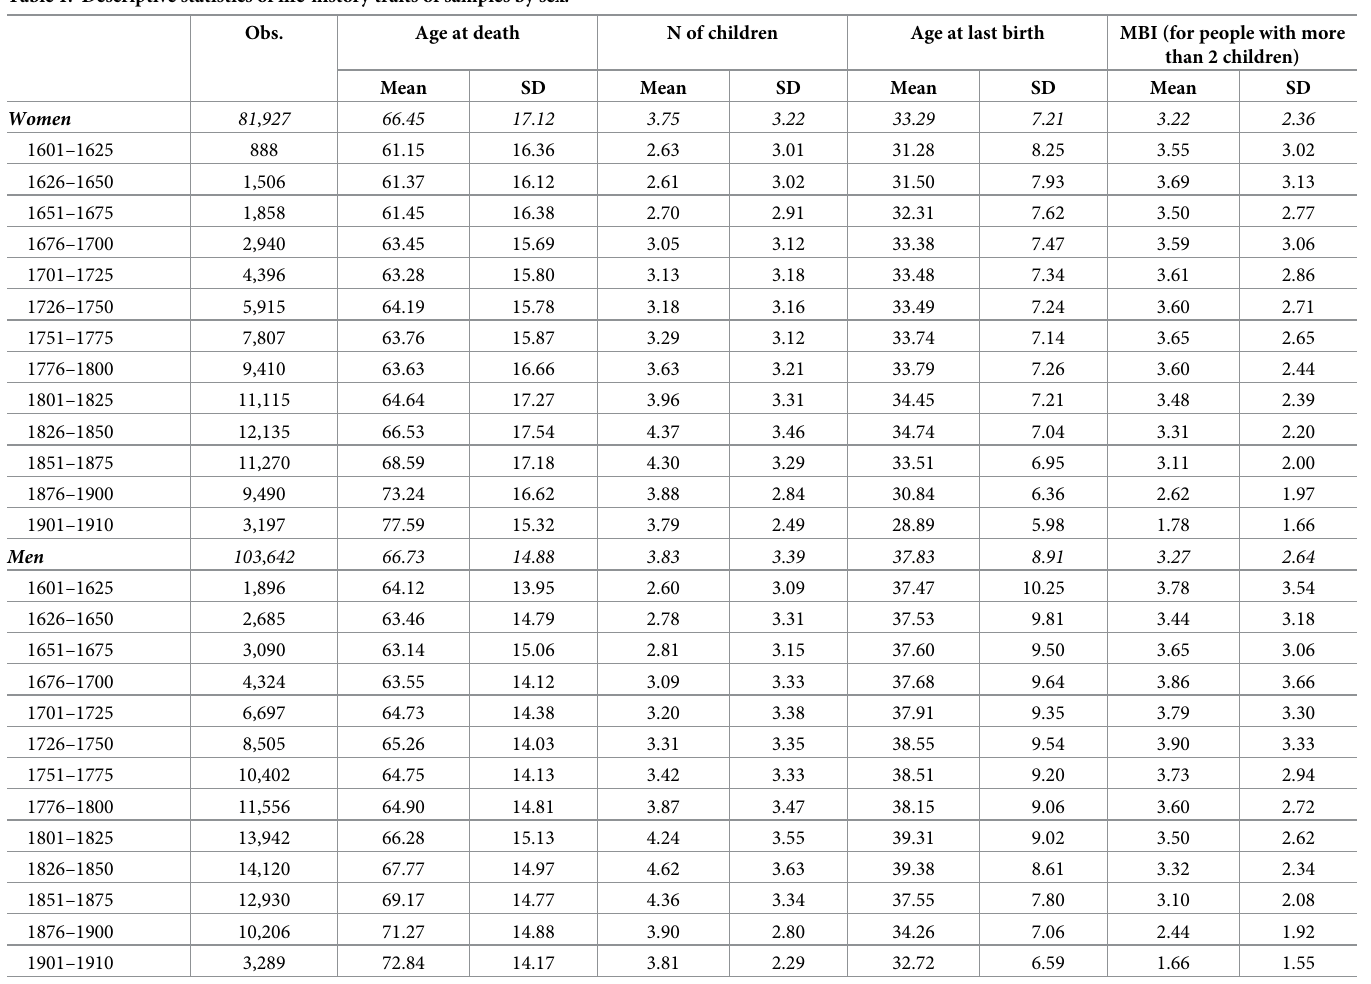
Table 1. Descriptive statistics of life-history traits of samples by sex.